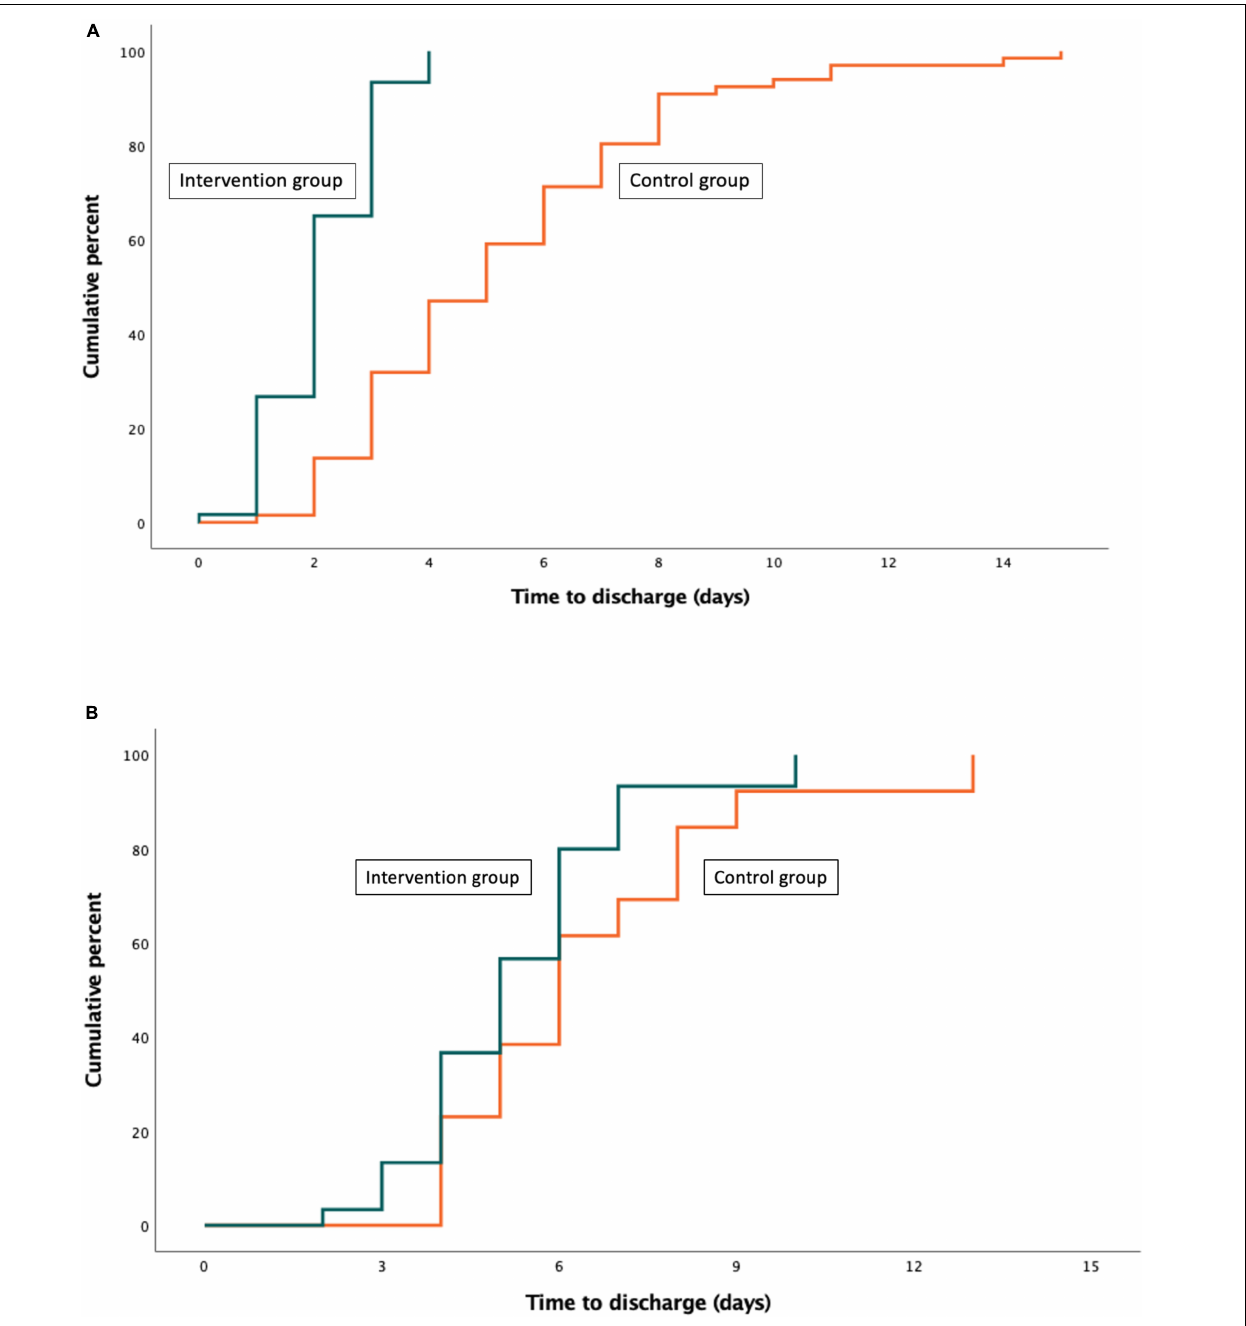
FIGURE 1 | Cumulative frequency distribution curve for the time to discharge of patients in the intervention group as compared with those in the control group. (A) Low-risk (B) Intermediate-high risk.